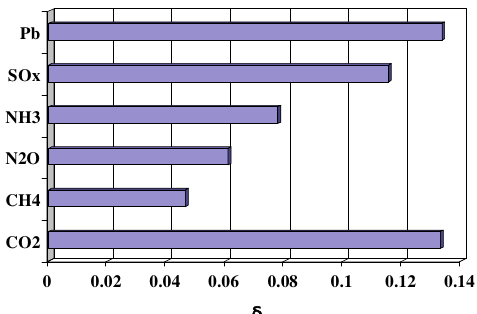
Fig. 16. The relative difference of national annual pollutant emission from motor vehicles in Poland comparing 2016 to 2015